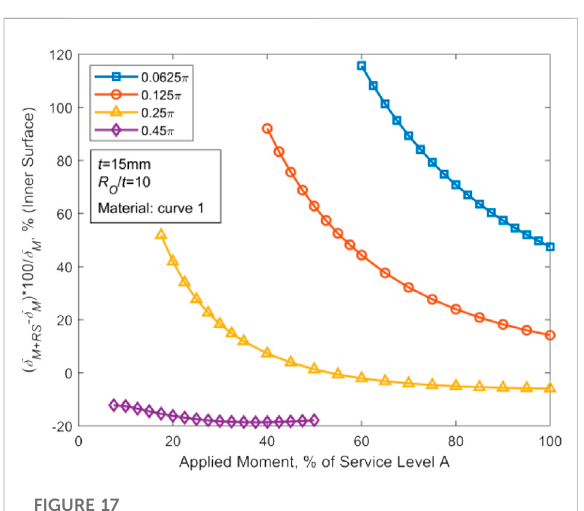
FIGURE 17 Variation of the inner wall Δ COD in terms of the stress level for various θ in the case of t = 15 mm, R O /t = 10, and material curve 1.